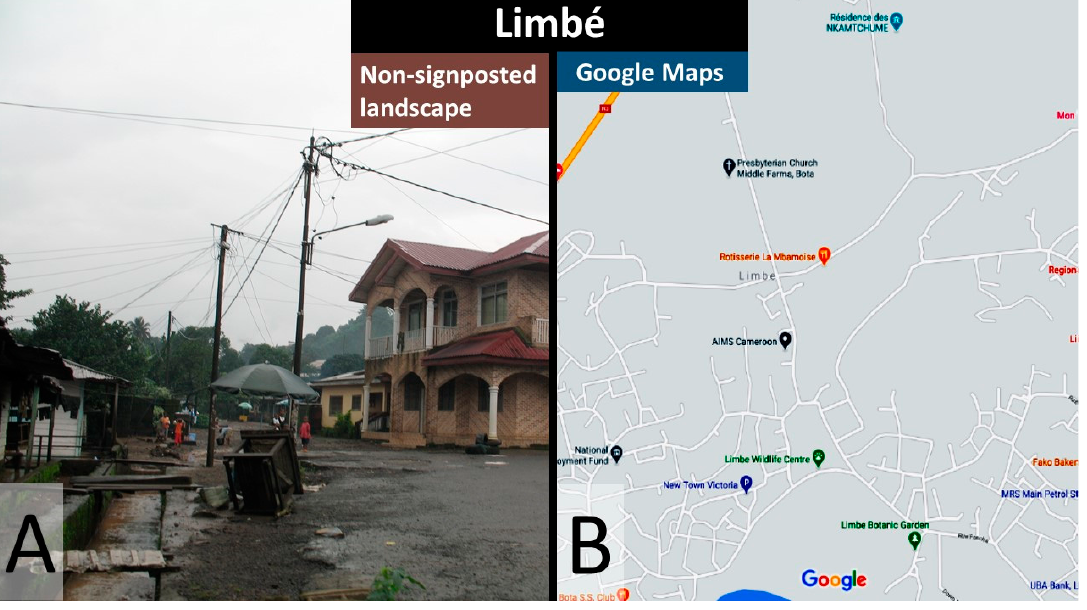
Figure 3. ( A ) The town of Limbé, Cameroon. Its nondescript address system on the ground (the streets have colonial and postcolonial names, but they are not signposted, while informally, from the viewpoint of the space-users, there is no nameless street) (author’s photo); ( B ) part of the town, as appearing on Google Maps, with public facilities and some private businesses indicated, also operating as landmarks (image in the public domain).